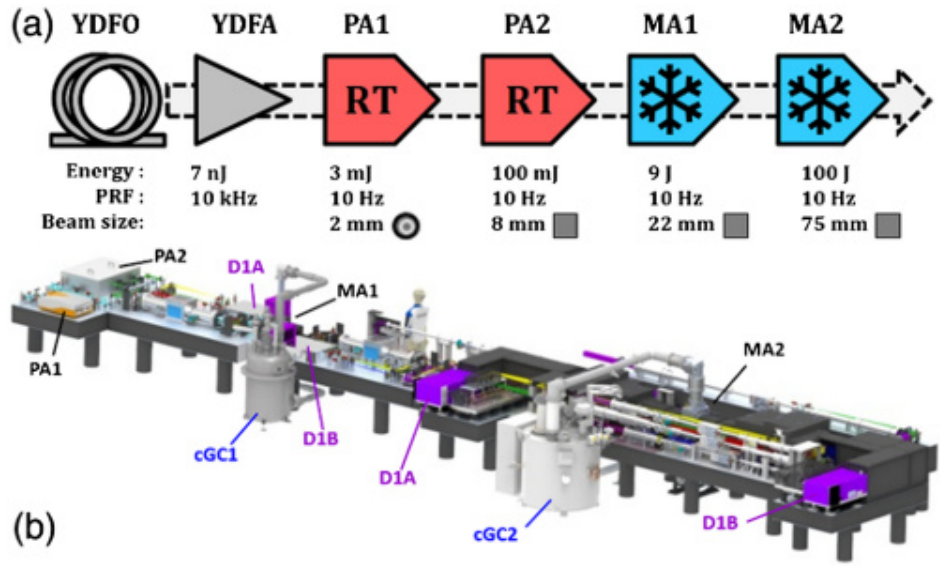
Figure 8. ( a ) Schematic of DiPOLE100 amplifier chain showing typical output performance after each amplifier stage, including free-space beam size and shape: YDFO = Yb-silica fiber oscillator; YDFA = Yb-silica fiber amplifier (inc. temporal pulse shaping); PA = room-temperature preamplifier (1 = Yb:CaF 2 regenerative, 2 = Yb:YAG multi-pass); MA = main cryogenic amplifier (ceramic Yb:YAG multi-slab); ( b ) a 3D model of DiPOLE100 system: D = diode pumps; cGC = cryogenic gas coolers